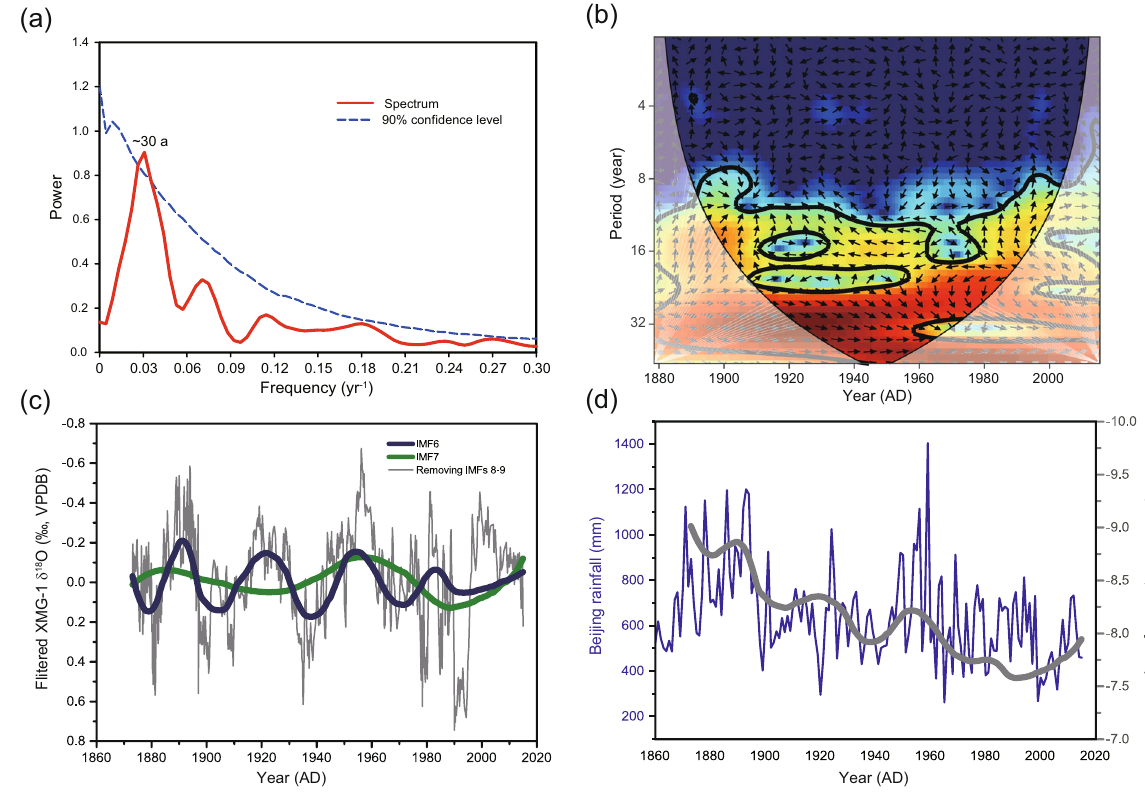
Figure 6. Time series analyses of the Shihua δ 18 O record and the PDO index. ( a ) Spectral analysis of XMG-1 δ 18 O record (red line) shows a period of ~30 years (labeled). The dashed line refers to the 90% confidence level. ( b ) The cross-wavelet transform of the PDO index and detrended XMG-1 δ 18 O time series (7-year moving average, 1873–2015 AD). The 5% significance level against red noise is shown as a thick contour. The relative phase relationship is shown as arrows (with in-phase pointing right and anti-phase pointing left) 61 . ( c ) Filtered XMG-1 δ 18 O record after subtracting the IMFs 8 and 9 from the original sequence (gray) (see Methods) superimposed by the IMF 6 (thick blue curve) and IMF 7 (thick olive curve), reflecting two modes of multidecadal oscillations (~30 and 50–70 years), respectively. ( d ) Beijing annual rainfall amount (blue) and the low frequcy variations in XMG-1 record represented by the IMFs 6–9 components (thick gray